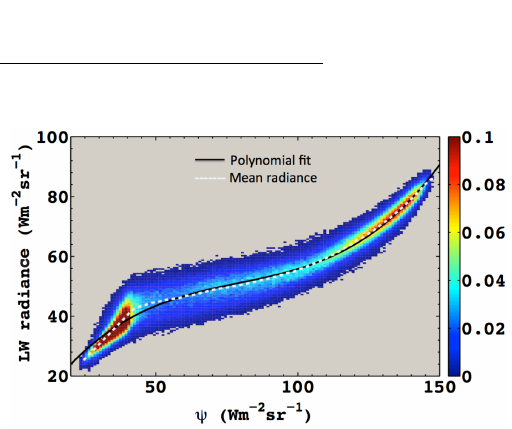
Figure 15. Observed LW radiances (contoured by percentage ) for nighttime overcast clouds over ocean surfaces with (cid:49)T sc > 85K, 300 <T s < 305K, w > 5cm, and 60 ◦ <θ < 62 ◦ plotted against pseudoradiance. Third-order polynomial fit is shown with solid black line, and mean radiance for each 1Wm − 2 sr − 1 bin is shown with broken white